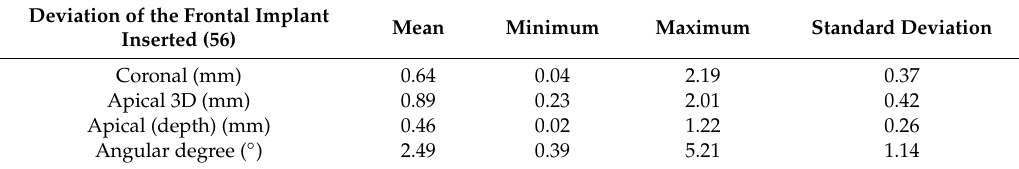
Table 3. Mean, maximum, and minimum of the coronal, apical 3D, apical vertical (depth), and angular deviations of the frontal implants inserted using a dynamic navigation system ( n = 56).